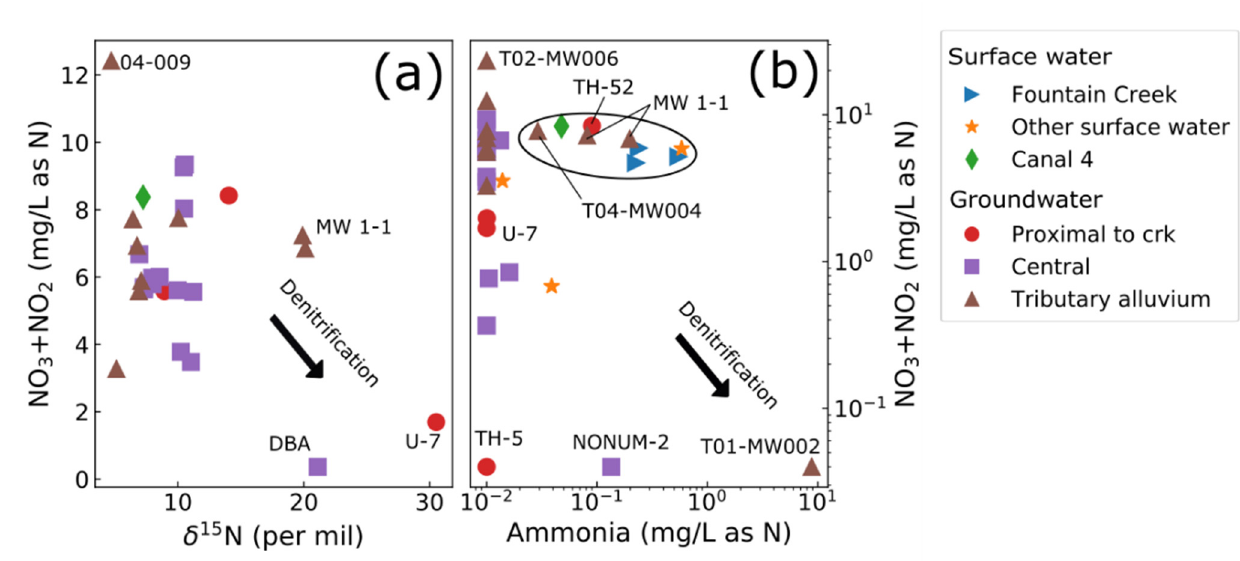
Figure 3. ( a ) NO 3 + NO 2 concentrations versus δ 15 N and ( b ) NO 3 + NO 2 concentrations versus ammonia concentrations in groundwater and surface water with specific wells labeled with site alias. Isotopes of N and concentrations of aqueous species are consistent with denitrification reactions in water from wells. The circled area on panel ( b ) corresponds to generally elevated ammonia and NO 3 + NO 2 concentrations likely influenced by WWTPs. The two plots do not show all the same wells, because not all wells that were sampled for ammonia and NO 3 + NO 2 were also sampled for nitrogen isotopes.